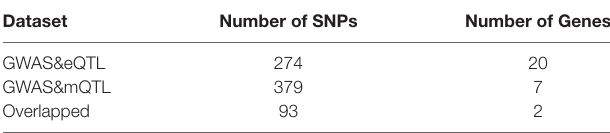
TABLE 2 | The results of summary data-based Mendelian randomization